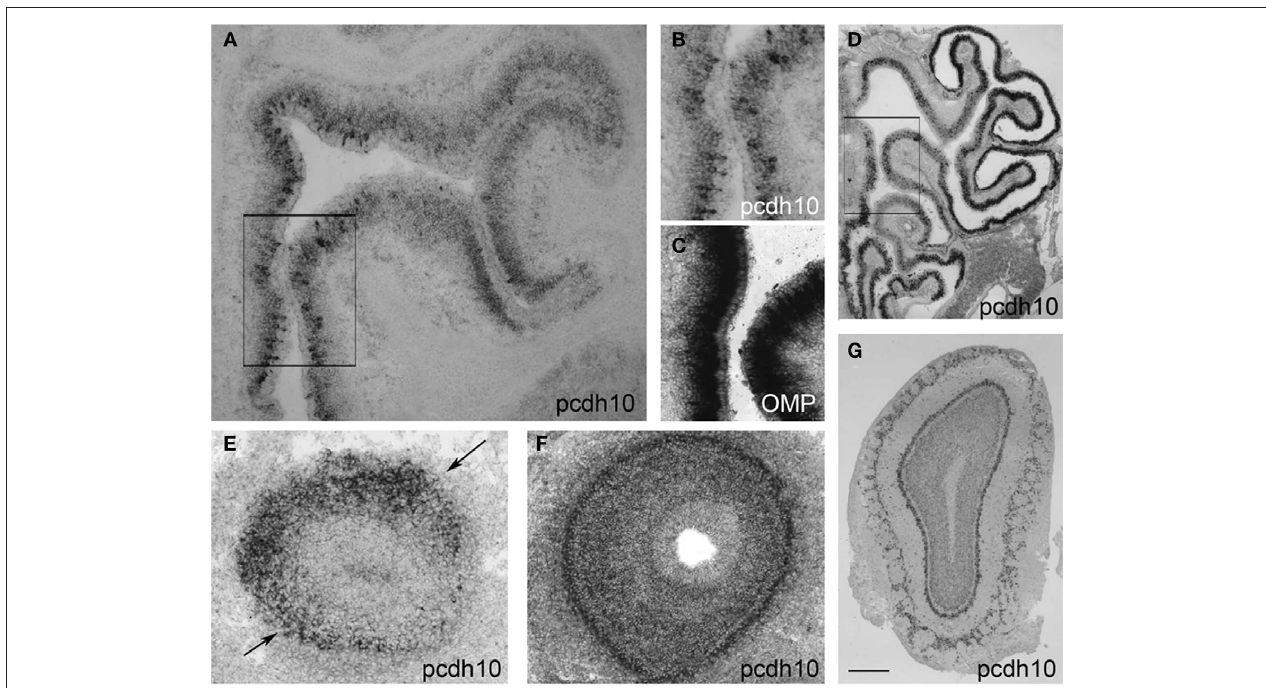
epithelium. However, the original pattern observed at E17.5 can still be seen in adulthood [compare boxed areas in (A) and (D) ]. In all bulbar images, medial is to the right. (e) Pcdh10 expression in E14.5 olfactory bulb labels a broad domain in the dorsolateral bulb (black arrows), but is weak or absent in the medial bulb. (F,g) Pcdh10 expression in E17.5 (F) and adult (g) bulbs appears uniformly distributed. Scale bar = 90 μm (A) , 30 μm (B,C) , 250 μm (D) , 50 μm (e,F) , 125 μm